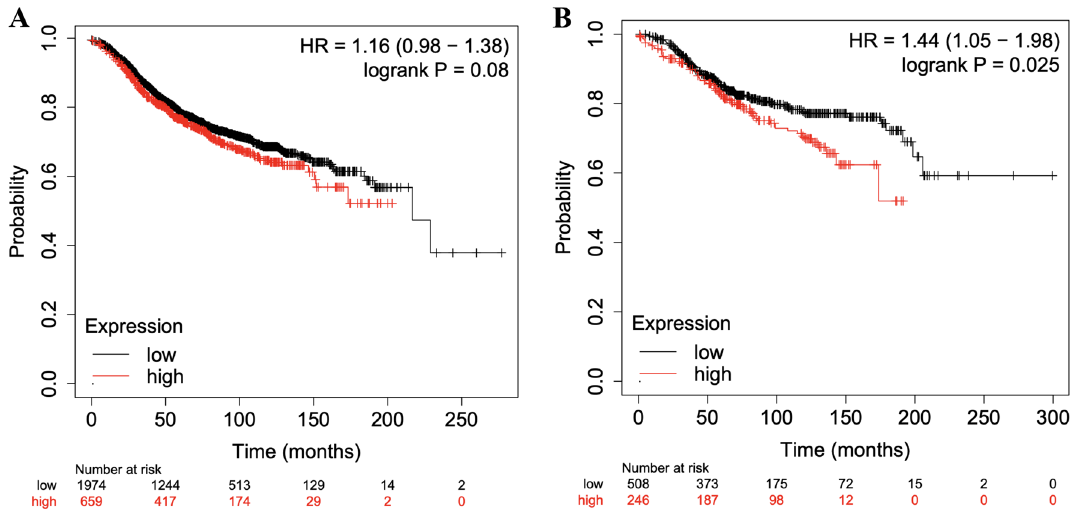
Figure 7. Kaplan–Meier plots of recurrence free survival ( A ) and overall survival ( B ) according to expression of RHOD in oestrogen receptor positive breast cancer by